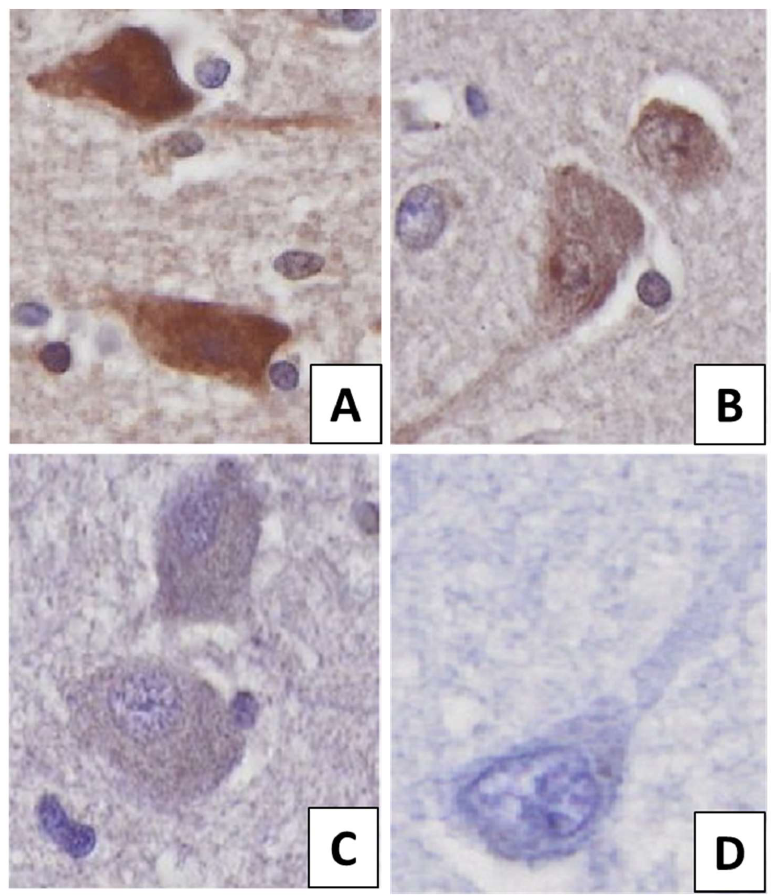
Figure 1. The different immunolabelling intensities in neurons: ( A ) strong positivity (3+), ( B ) mod- erate positivity (2+), ( C ) mild positivity (1+), ( D ) negative (0). The protein was visualized by 3,3′- Diaminobenzidine (DAB) chromogen. Nuclear counterstain with haematoxylin.